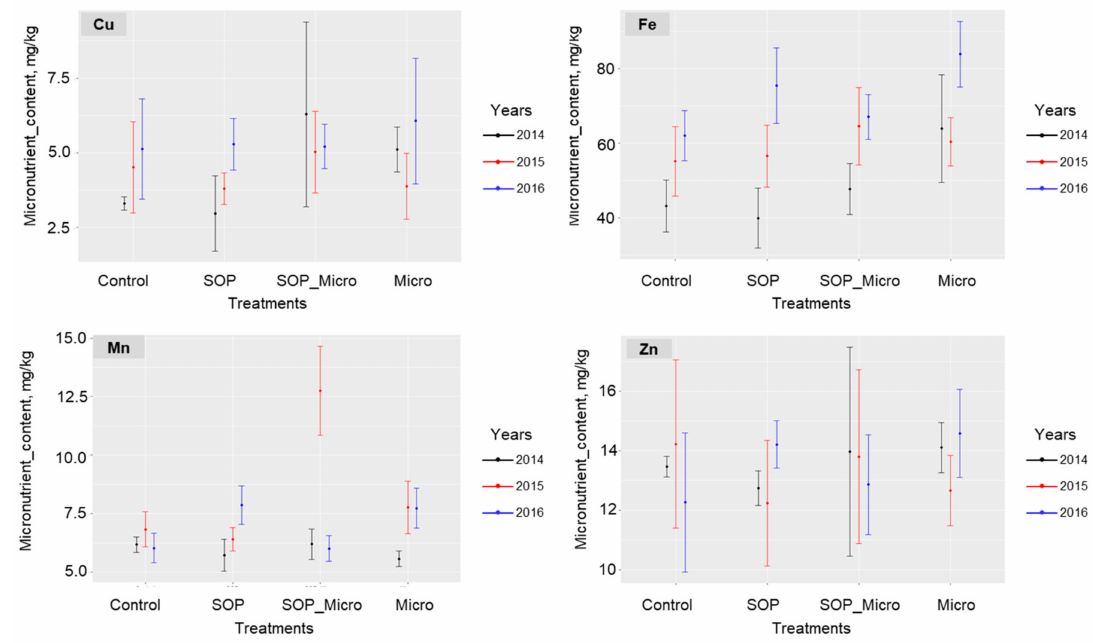
Figure 3. E ff ect of foliar fertilization with potassium and micronutrients on micronutrient content in potato tubers in the variety Zorba at the stage in full maturity.